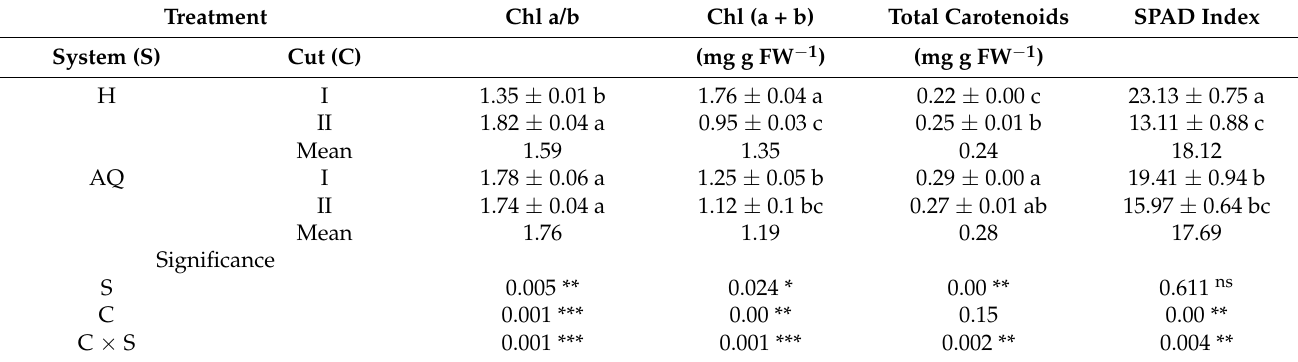
Table 4. Photosynthetic pigments content in terms of chlorophyll (a+b) , carotenoids, Chl a/b ratio, and SPAD values Genovese basil cv Sanremo plants under two consecutive cuts (35 (I) and at 79 (II) days after planting (DAP)) grown under hydroponics (H) or aquaponics (AQ) conditions.